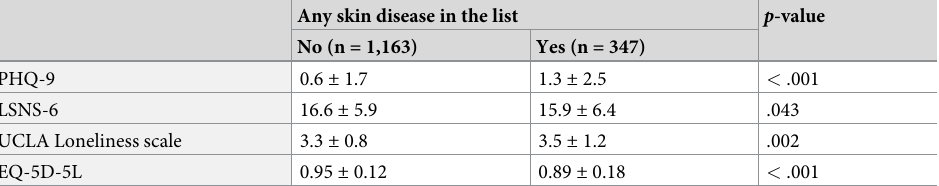
Table 4. Comparison of PHQ-9, LSNS-6, UCLA loneliness scale and EQ-5D-5L index scores between participants with and without any listed skin diseases, mean ± SD. Any skin disease in the list